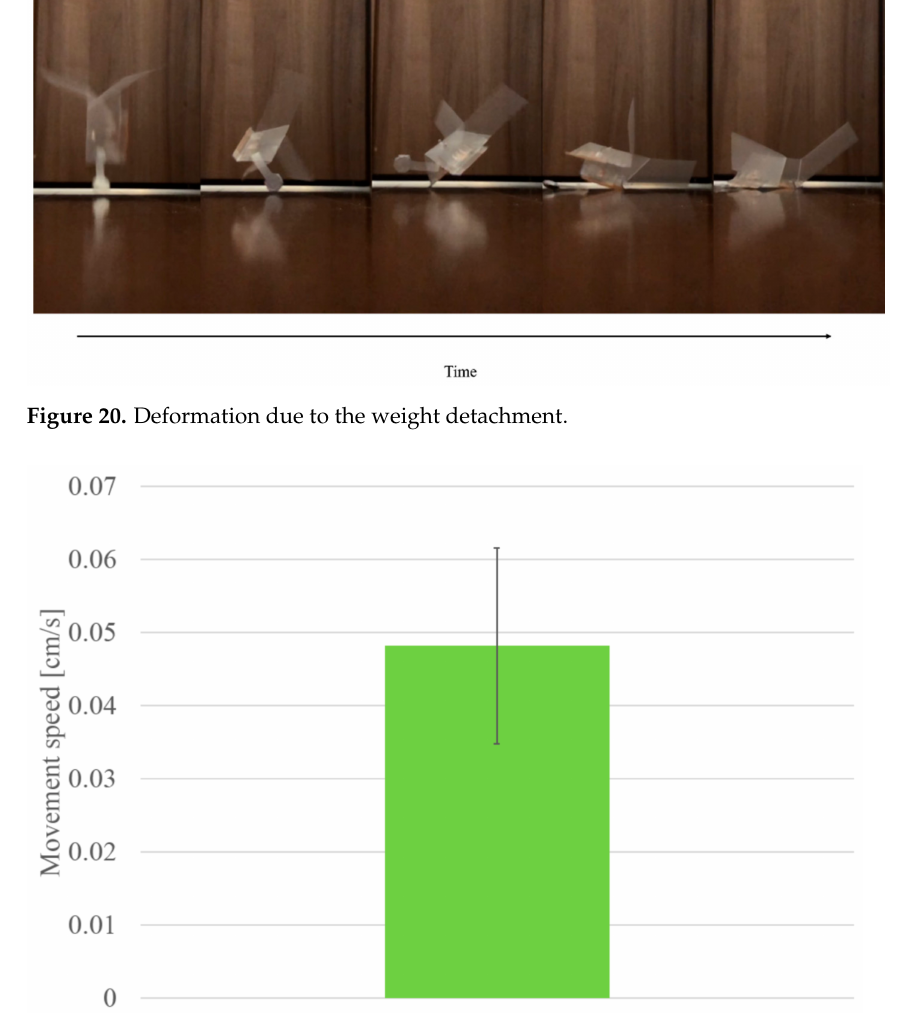
Figure 21. Experimental results of movement